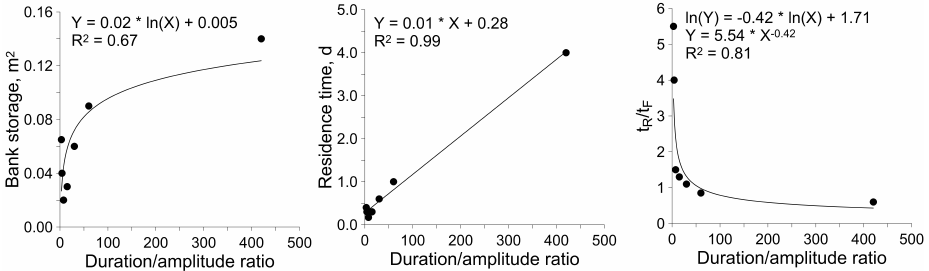
Figure 9. Duration/amplitude ratio in relation to bank storage, residence time and return/fill time ratio ( t R / t F ) for all waves exceeding 0.1m